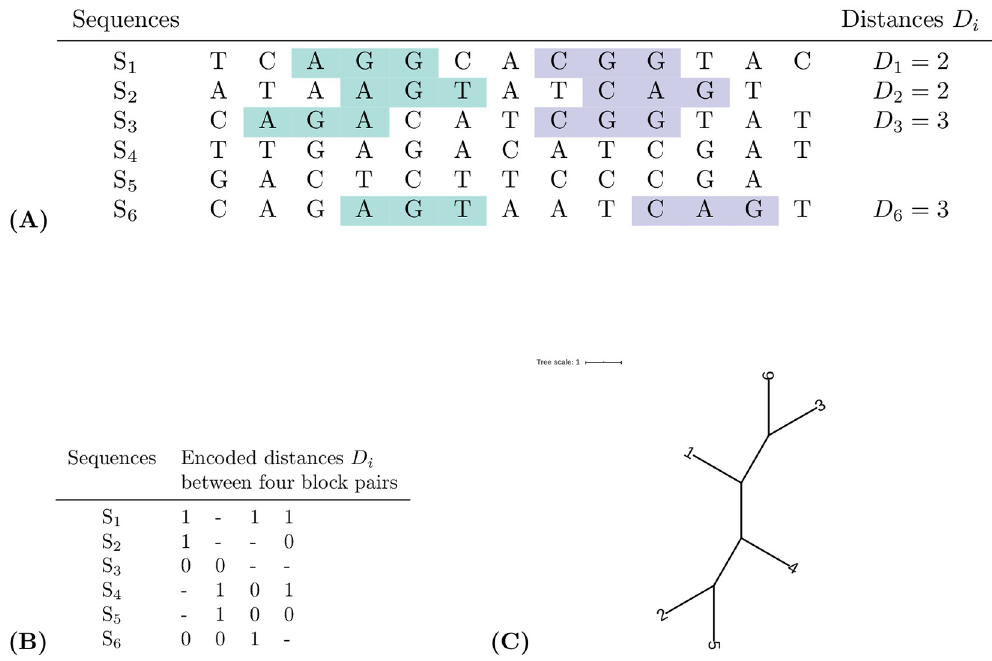
Fig 5. (A) Single block pair in a set of 6 sequences and distances D , (B) character matrix encoding distances D from four i i different quartet-block pairs and (C) tree topology, calculated from this matrix with maximum parsimony . Each column in the matrix represents one informative block pair. For the four sequences involved in a block pair, the distances D are i represented by characters ‘0’ and ‘1’, such that equal distances are represented by the same character. The characters themselves are arbitrary, the matrix only encodes if the distances D between two blocks are equal or different in the four i involved sequences. Dashes in a column represent ‘missing information’, for sequences that are not involved in the respective quartet-block pair. The quartet-block pair in (A) would be represented by the first column of the matrix (B) , as we have D 1 = D 2 6¼ D 3 = D 6 . Thus, for S 1 and S 2 we have the same (arbitrary) symbol ‘1’, while S 3 and S 6 we have the symbol ‘0’. Since S 4 and S 5 are not involved in this quartet-block pair, they have dashes in the first column, representing ‘missing information’. The matrix represents four quartet-block pairs that strongly support one quartet topology, namely column 1 supporting S 1 S 2 | S 3 S 6 , column 2 supporting S 3 S 6 | S 4 S 5 , column 3 supporting S 1 S 6 | S 4 S 5 and column 4 supporting S 1 S 4 | S 2 S 5